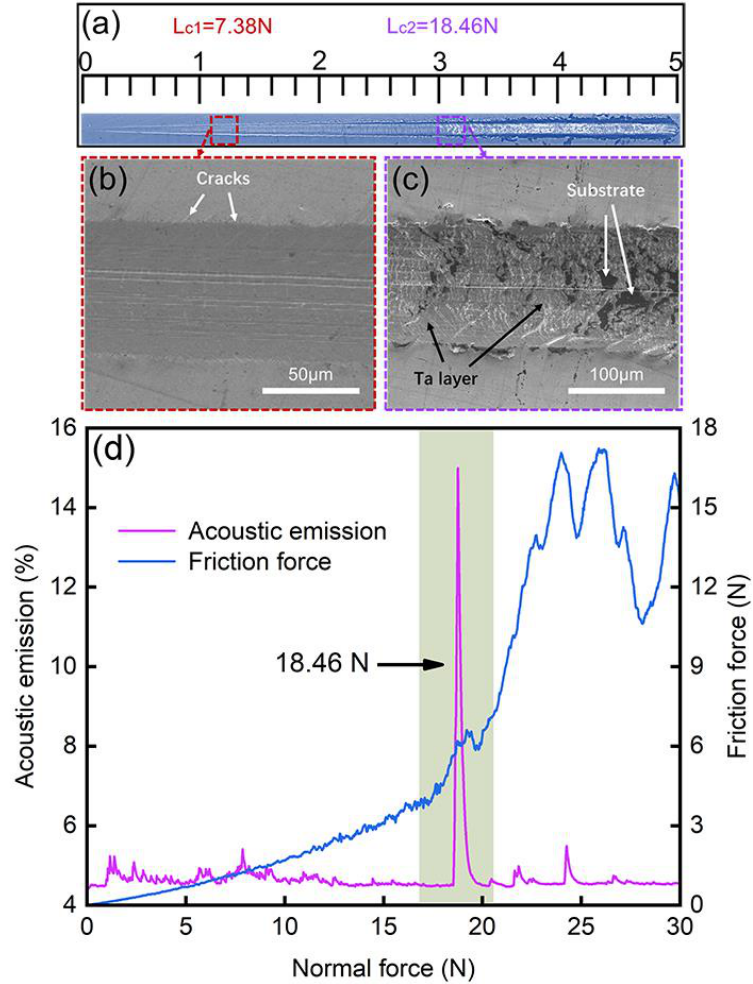
Figure 11. Scratch results of Ta coating prepared at 400 °C-100 W ( a ) OM of the scratch, ( b , c ) SEM morphology of the selected areas in Figure 4a, and ( d ) the micro scratch curve.